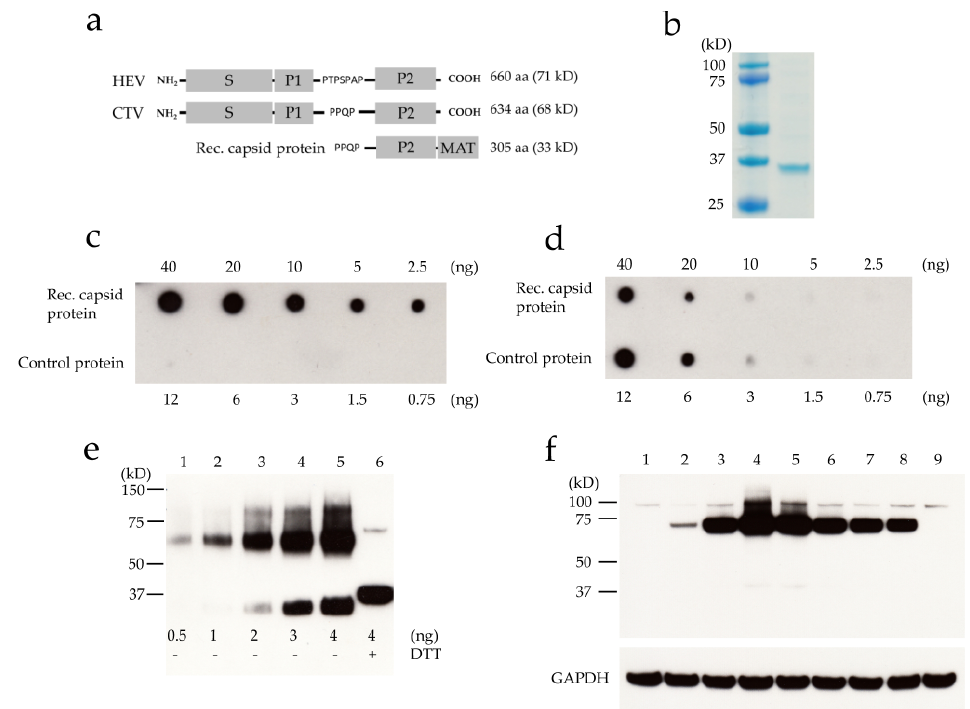
Figure 3. Generation of an antibody directed against the ORF2-encoded capsid protein. ( a ) Schematic representation of hepatitis E virus (HEV) and CTV ORF2-encoded protein domains and the region selected for antibody generation; ( b ) Reducing SDS-PAGE analysis of the affinity purified rec. capsid protein by staining with colloidal Coomassie stain; Dot blot detection of rec. capsid protein and metal affinity tag (MAT) tagged control protein using ( c ) anti-capsid protein antibody and ( d ) anti-MAT antibody; ( e ) Western blot analysis of the recombinant capsid protein at different concentrations (lanes 1–5) and treated with 100 mM Dithiothreitol (DTT) (lane 6); ( f ) Western blot detection of ORF2-encoded protein expression in infected RTGill-W1 cells over a time period of 12 days, using anti-capsid protein antibody; lanes 1 through 6 represent the respective days post-infection (pi); lane 7 represents day 8 pi; lane 8 represents day 12 pi; lane 9 was used as a negative control,